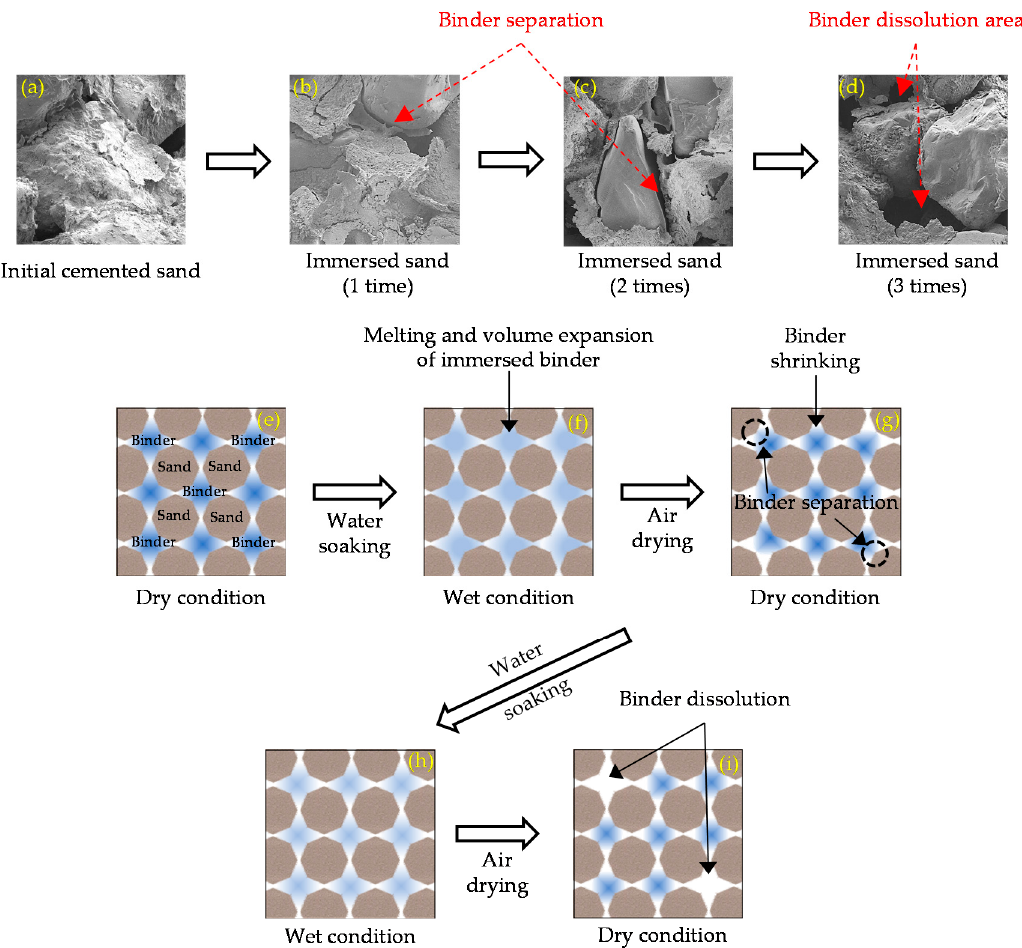
Figure 10. SEM micrographs of repeatedly soaked samples ( a – d ), and the diagrams of particle behavior ( e – i ).